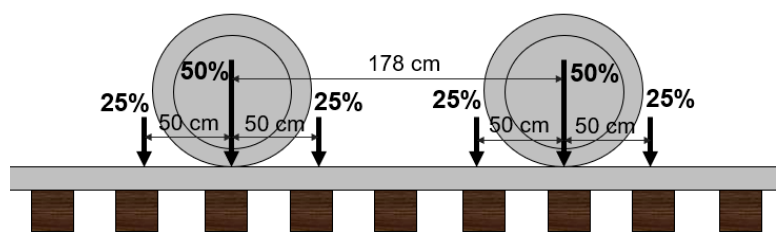
Figure 6. Set of forces corresponding to axles load.